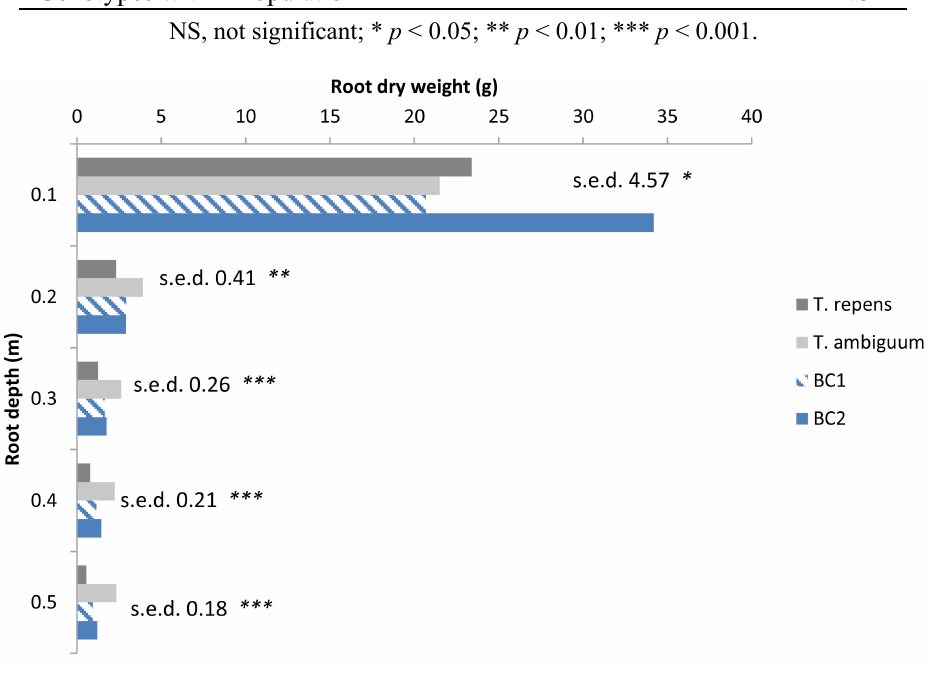
Figure 1. Root dry weight in 0.1 m sections of soil columns containing Caucasian clover, white clover, BC1 and BC2 hybrids. NS, not significant; * p < 0.05; ** p < 0.01; *** p <